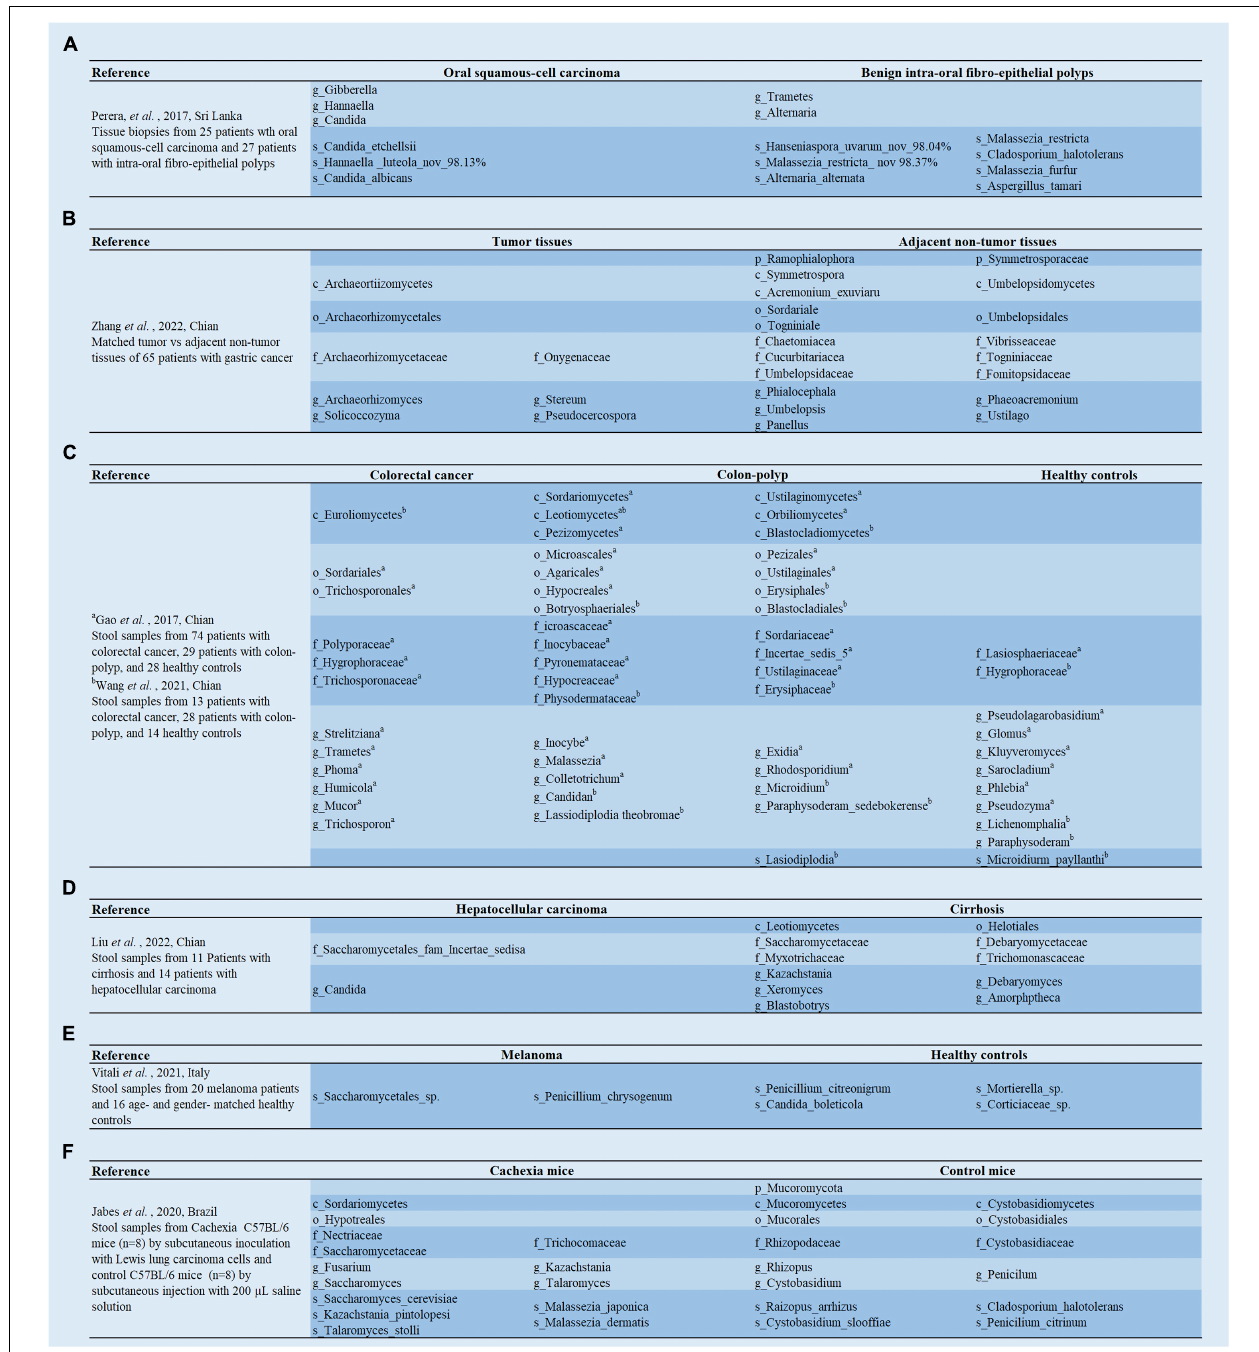
FIGURE 2 | (A–F) Analysis of the linear discriminant analysis effect size (LEfSe) in gut mycobiota between cancer patients and healthy controls.